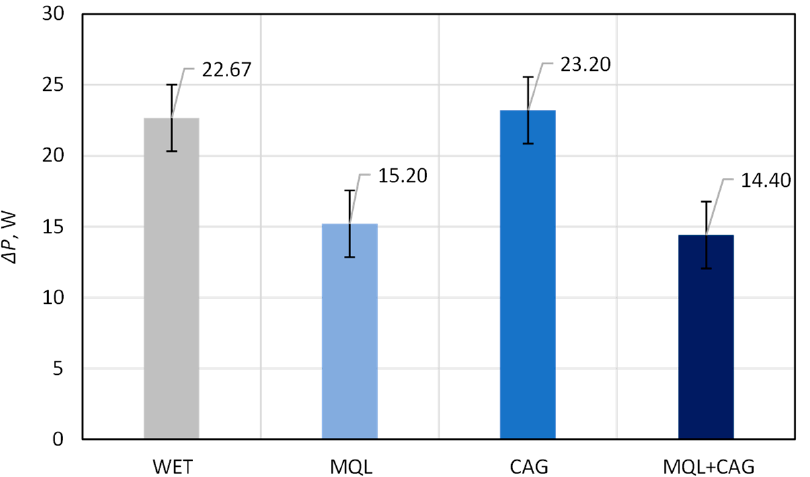
Figure 4. The average values of the grinding power gain Δ P determined during grinding tests carried out with 5 repetitions using four methods of delivering coolants to the machining zone (flooding method WET, MQL, cooling using cooled compressed air generated by CAG nozzle and the hybrid method MQL + CAG) (error bars represent the standard error equal to the standard deviation σ divided by the square root of the total number of samples).